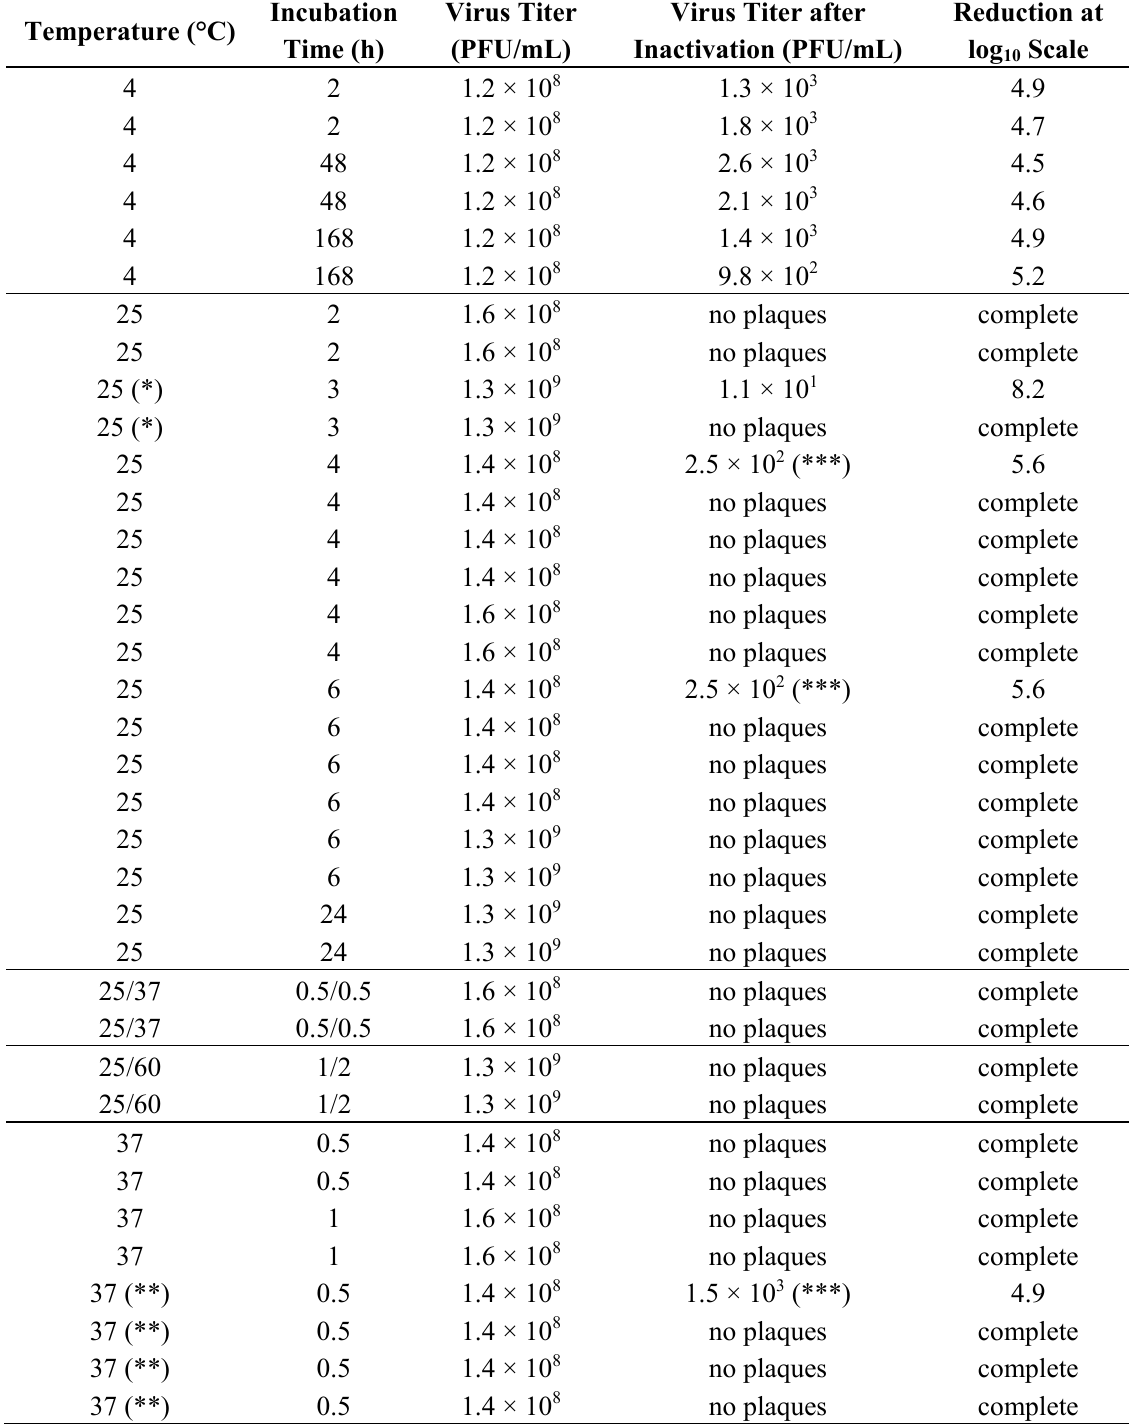
Table 1. Efficiency of Vaccinia virus inactivation by 2% formaldehyde (if not stated otherwise) in relation to temperature and incubation time. Virus titer was determined by plaque